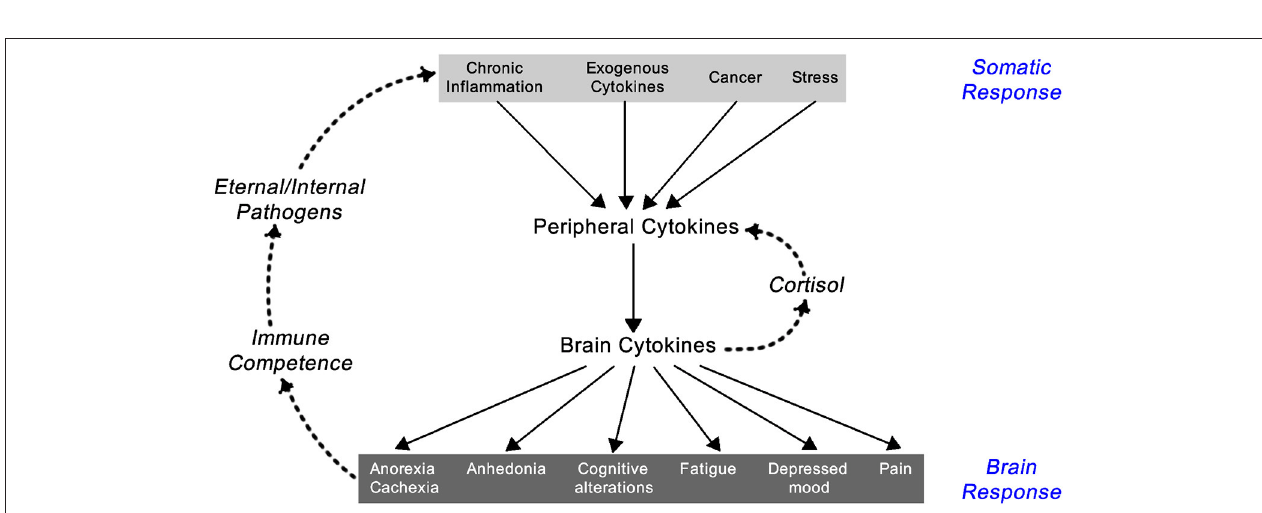
FIGURE 2 | Feedback loop between the somatic and central nervous system components of the inflammatory response [exogenous cytokines are typically synthetically made cytokines used as treatment for a variety of immune-related diseases like IFN- α for hepatitis C infection or IL-2 for renal cell carcinoma; adapted from Dantzer